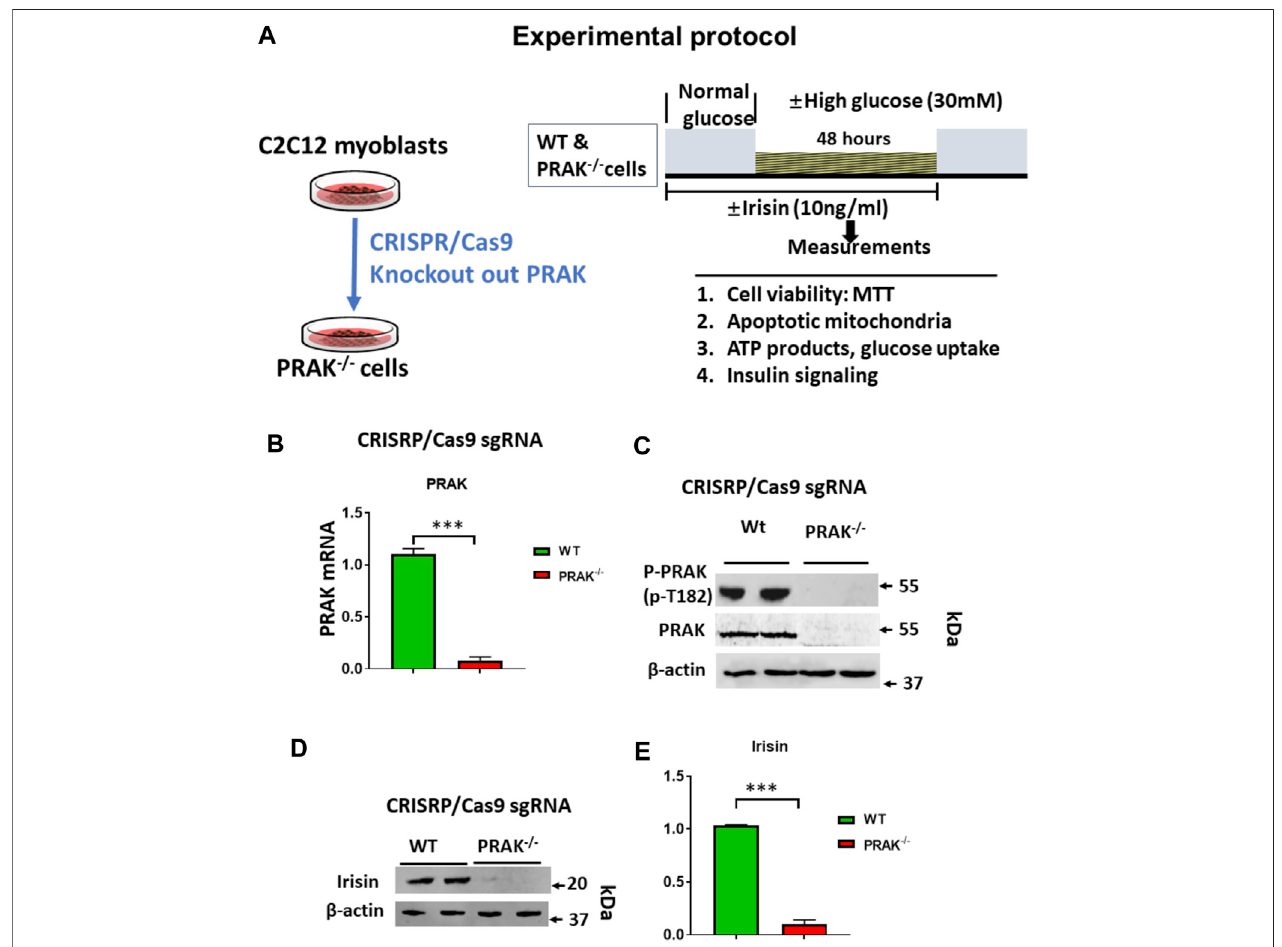
FIGURE 1 | (A) : Experimental protocol: Generation of PRAK − / − C2C12 cell lines using CRISPR/Cas 9 genome editing technology. CRISPR/Cas9 vector; sgRNA sequence; Myoblasts were differentiated to myotubes in which BSA medium was reduced from 10 to 2.5%, and C2C12 cells were cultured for 3 days to 1 week; high glucose(30 mM),normalglucose(5.6 mM)experimentalprotocolinC2C12myoblasts. (B) :qPCRdetectedmRNAofPRAKinwildtypeandPRAK − / − C2C12cells( n (cid:2) 3/ each group); Values represent means ± SEM ( n (cid:2) 3/group), *** p < 0.001. (C) : Western blot showed the absence of PRAK protein in PRAK − / − C2C12 cells; (D) : Westernblotshowedareduction ofirisininPRAK − / − cells; (E) :Densitometricanalysisshowsthereduction ofirisininPRAK − / − cells;Values represent means ± SE( n (cid:2) 5/ each group), *** p <